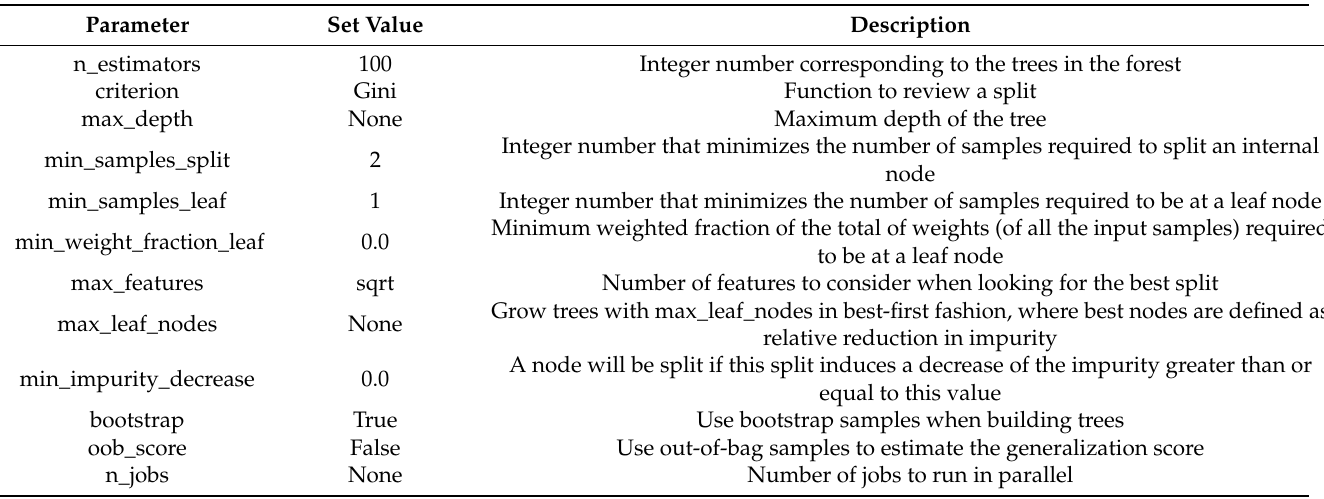
Table 11. Parameters of mechanism set for